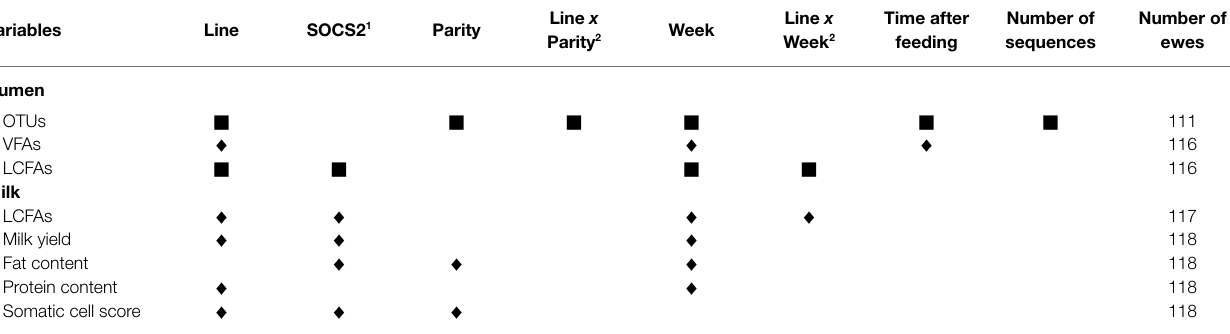
TABLE 2 | Models for OTUs, VFAs, long-chain fatty acids (LCFAs) in the rumen, milk yield, fat and protein contents, somatic cell score, and LCFAs in the milk.